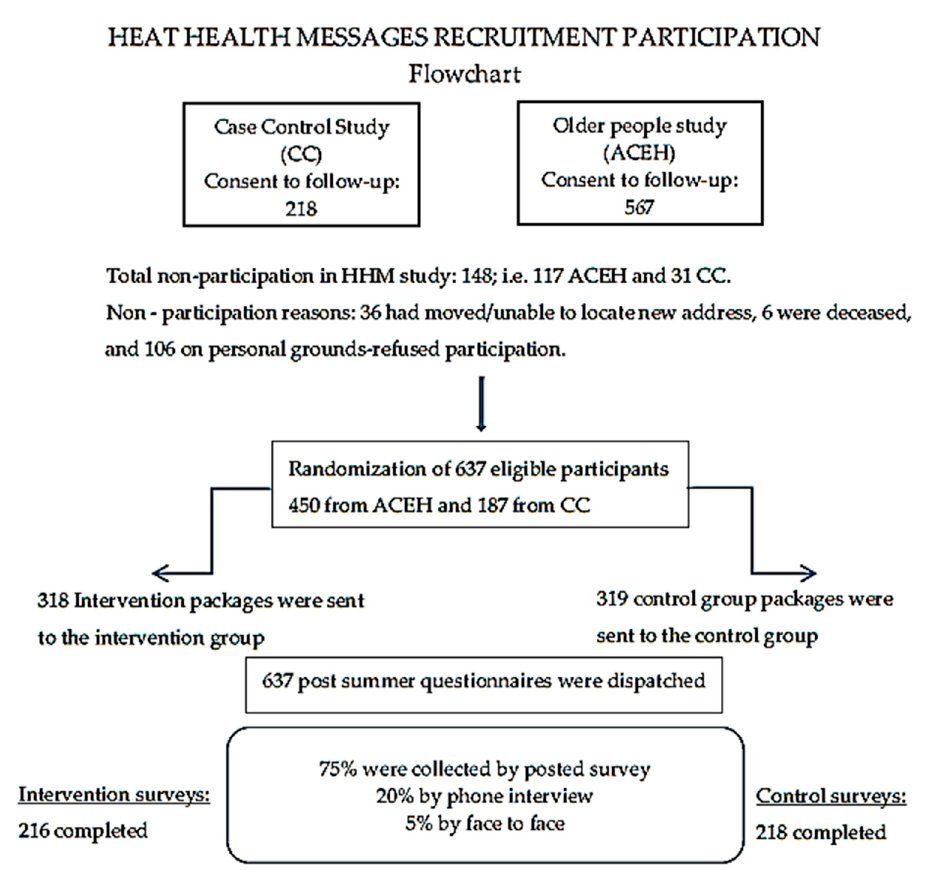
Figure 1. Flowchart of recruitment, randomization and study processes.